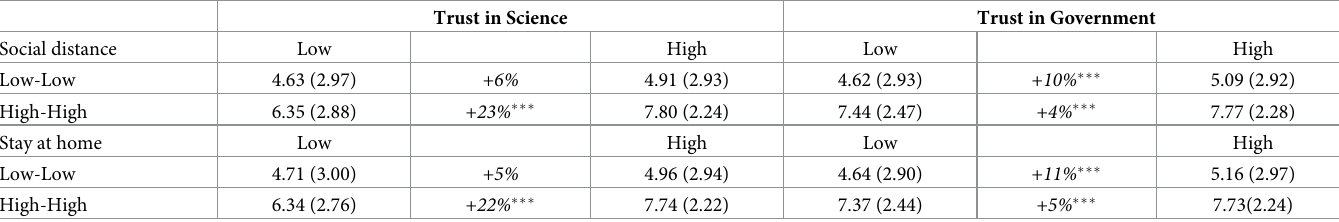
Table 3. Compliance likelihood and trust in science and government.